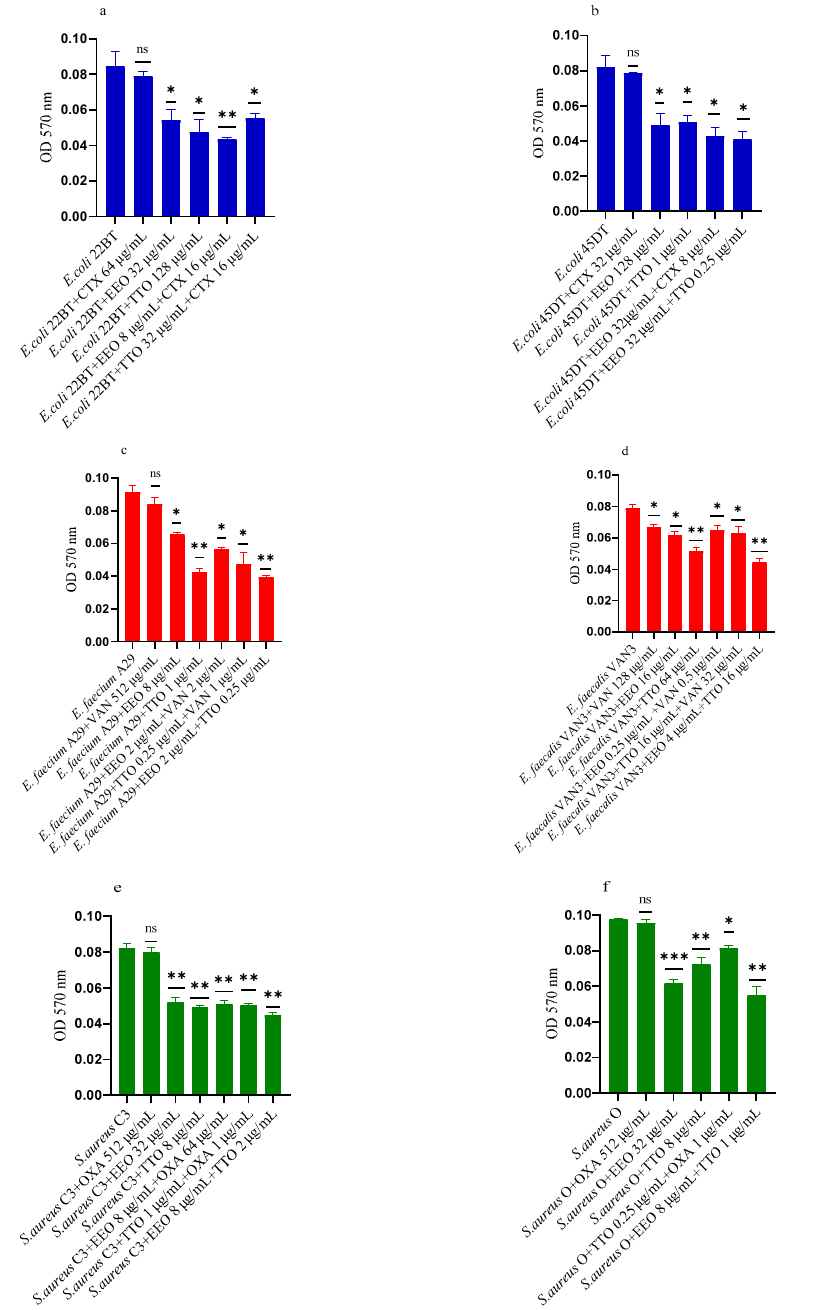
Figure 5. Anti-mature biofilm activity of Melaleuca alternifolia (TTO) and Eucalyptus globulus (EEO) EOs, of antimicrobials (cefotaxime -CTX-, vancomycin –VAN- and oxacillin-OXA-), and of different combinations/association (antimicrobial/EO and EO/EO) against ( a ) ESBL Escherichia coli 22 BT, ( b ) ESBL Escherichia coli 45DT, ( c ) VRE Enterococcus faecium A29, ( d ) VRE Enterococcus faecalis VAN3 ( e ) MRSA Staphylococcus aureus C3 and ( f ) MRSA Staphylococcus aureus O strains. Results were ex- pressed in optical density (OD) 570 nm as the arithmetic mean of the three determinations. p -values of <0.05 (*), p < 0.01 (**), p < 0.001 (***) were considered significant by t-test and ANOVA. using statistical program GraphPad Prism 9.2.0 (San Diego, CA, USA). ns stands for not statistically sig- nificant. Against ESBL E. coli 22BT (Figure 5a), TTO was more effective than EEO, and its ac- tivity is maintained when combined with cefotaxime ( p < 0.01) but using lower concentra- tions than the single compounds. On the strain ESBL E. coli 45DT (Figure 5b) 1/4 MICs of the association EEO/TTO and combination EEO/cefotaxime could reduce the mature bio- film.